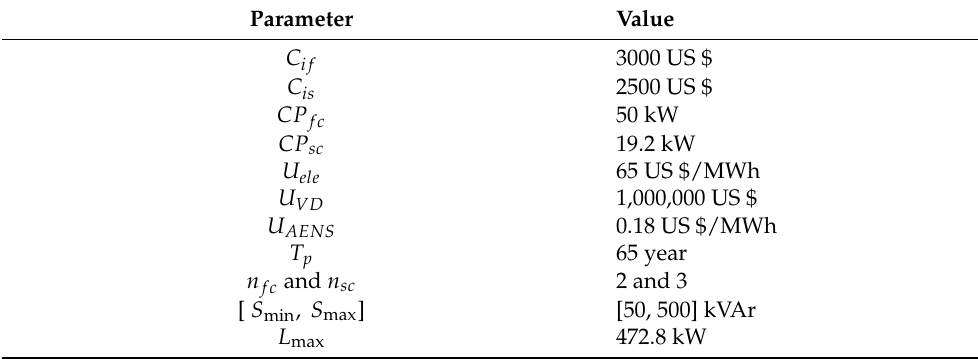
Table 4. Input parameters for the charging station placement problem